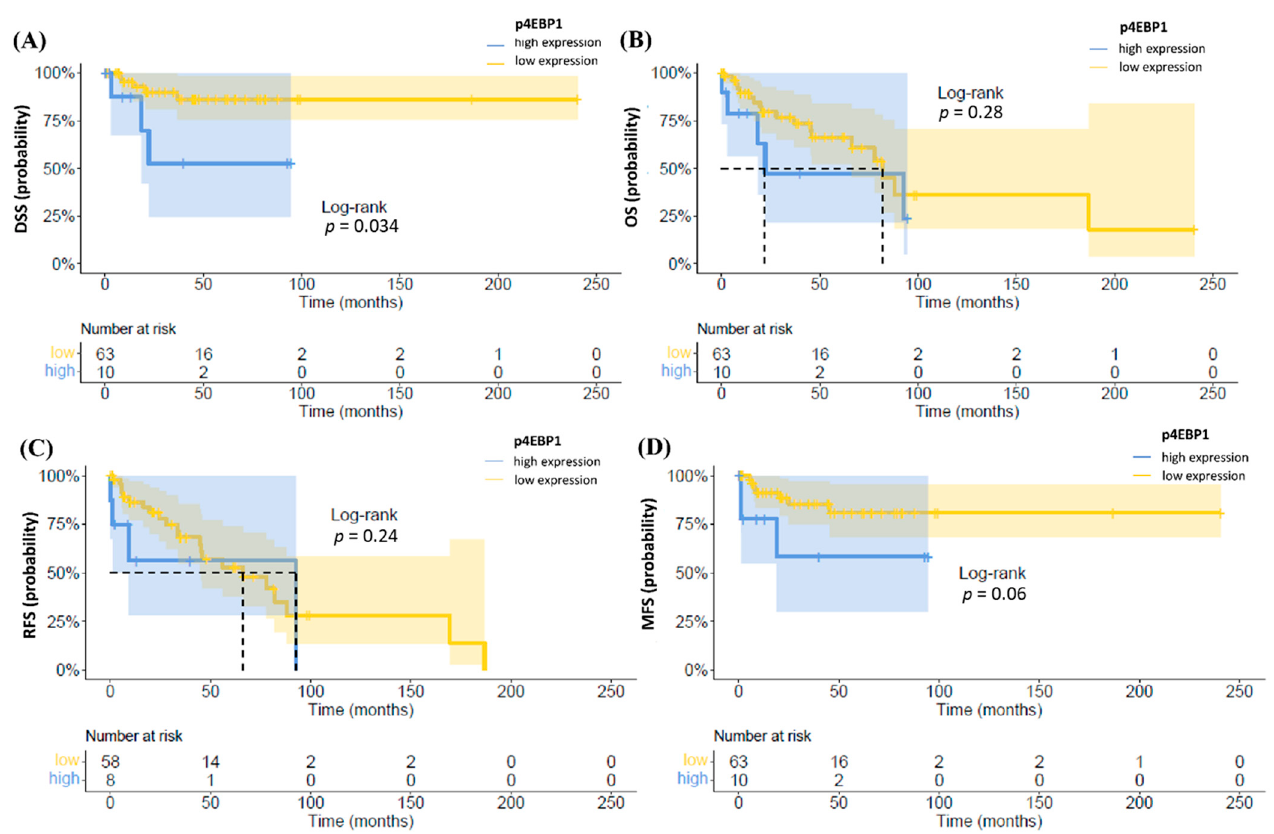
Figure 4. Kaplan–Meier plots of DSS ( A ), OS ( B ), RFS ( C ) and MFS ( D ) according to p4EBP1. High expression of p4EBP1 was associated with decreased DSS ( p = 0.034).